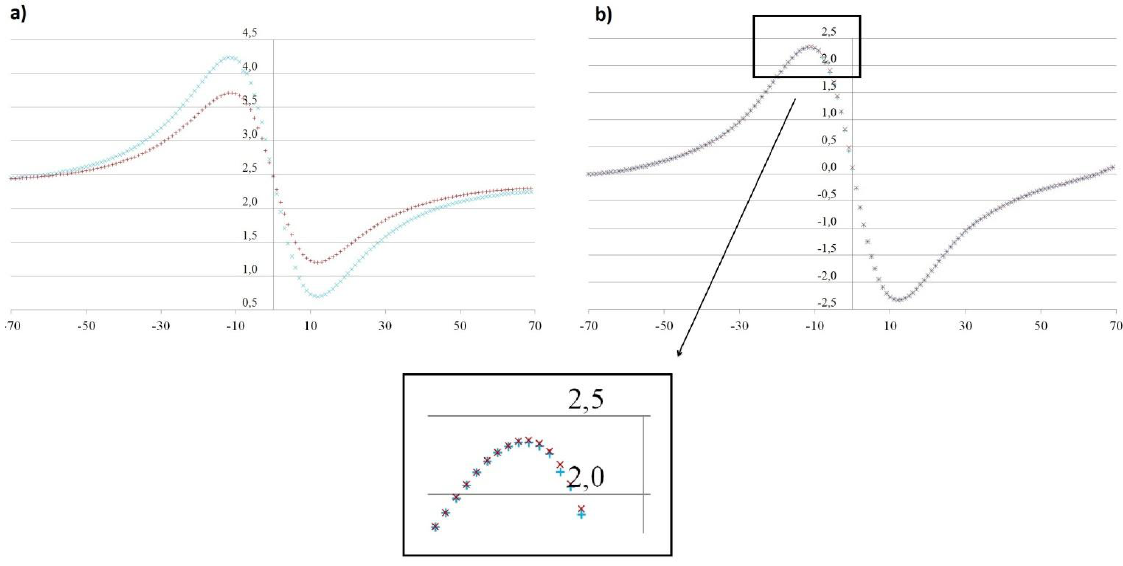
Figure 3. ( a ) Potential in volts (vertical axis) as a function of the position (mm) of the magnet with respect to a sensor in the center of the array (horizontal axis). Graphic in blue corresponds to the magnet without heat treatment, the red one corresponds to the magnet with heat treated. ( b ) Normalized value of the potential, for both magnet without heat treatment (blue) and treated (red). A value of zero on the horizontal axis indicates coincidence of positions (position of the sensor equal to the magnet position). We have made a zoom to see the difference between both